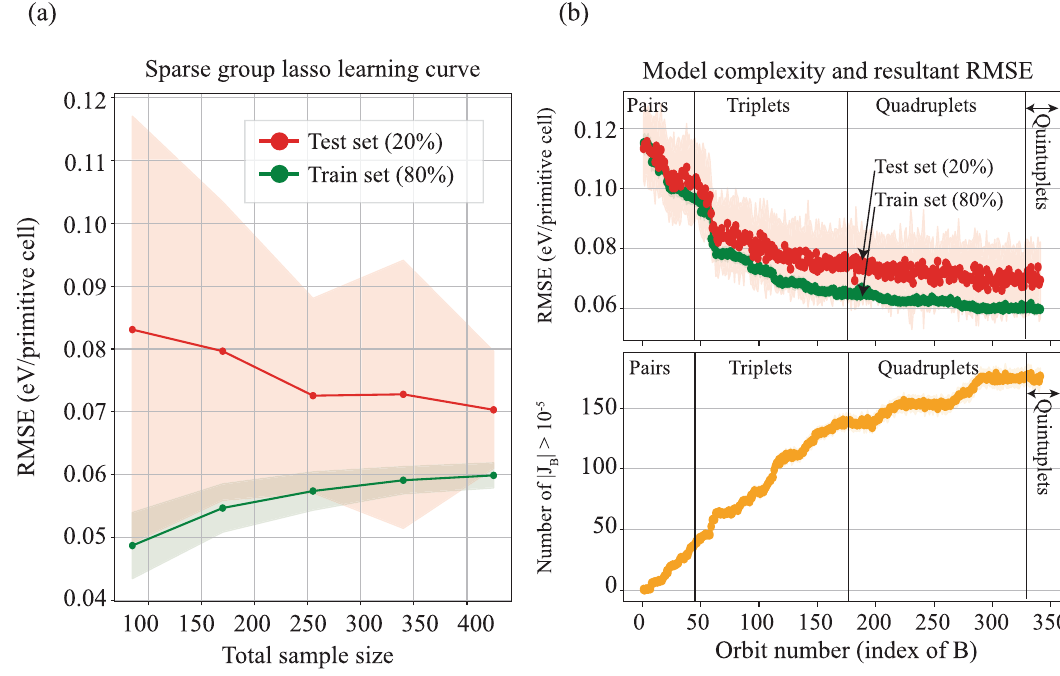
Fig. 5 Loss as a function of sample size and model complexity. The green (red) colors indicate the average and standard deviation of the loss for training (testing) in 50 cross-validation trials, setting aside 80% of the 428 structures for training and 20% for testing. a The learning curve for SGL with a loss function of root mean squared error (RMSE) per primitive cell as a function of sample size. The chosen hyperparameters are α = 0.056 and λ = 0.5. b The RMSE as a function of model complexity, starting from including only the fi rst orbit in a pair cluster and ending with including all geometric clusters up to quintuplets. Each individual model always uses the Ewald energy and all features in orbits up to the orbit number indicated. The number of signi fi cant features selected for each model is in yellow, showing how the number of ECI increases to over 150 in the last indicating the model fi tting was halted prematurely. On the other hand, over- fi t models diverge in training and cross-validation RMSE because the model has been over- fi t to the training samples. The learning curve in Fig. 5a shows the typical behavior of testing and training 64 , where with few training samples the model has enough free parameters to completely model the training set, so the training error is small. This sampling is not indicative of the test set so the out-of-sample error is high. With increasing training set size, the test error decreases. As we further increase the training set size, a testing RMSE of around 70 meV/primitive cell and training error of around 60 meV/primitive cell are reached. Figure S3 applies early theoretical work by Cortes et al. 65 in the convergence of learning curves, to project that the asymptotic RMSE convergence for PDS is 70 meV/primitive cell, indicating that more structure sampling is not expected to reduce the error in Fig. 5a. This convergence is not a property of the group lasso, but the best achievable performance among “ all ” models 62,65 . In CE, it is generally known and demonstrated through examples that better predictability can be achieved if more interactions are considered 66 . We apply this concept in the capacity curve in Fig. 5b, carrying out 50 cross-validation trials, again setting aside 80% of the 428 structures for training and 20% for testing. We build increasingly complex models by including more orbits, and always fi tting with the Ewald energy. By adding more orbits in B, we fi nd that both training and testing RMSE converge to 60 meV/primitive cell and 70 meV/primitive cell, respectively, approaching the limiting performance or asymptotic performance of the data 62 .